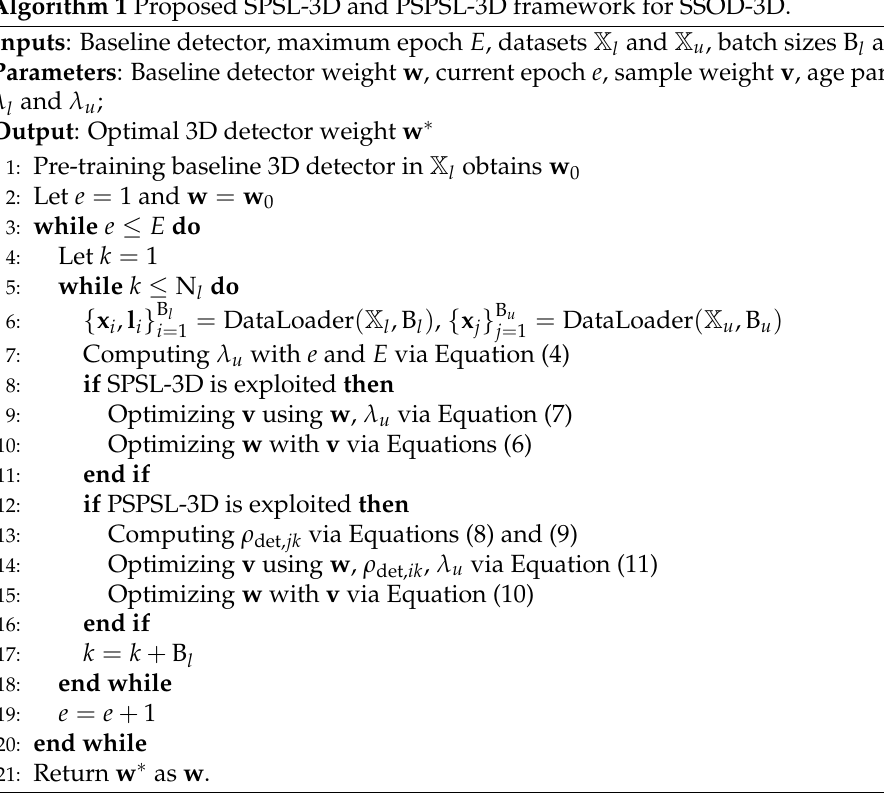
Algorithm 1 Proposed SPSL-3D and PSPSL-3D framework for